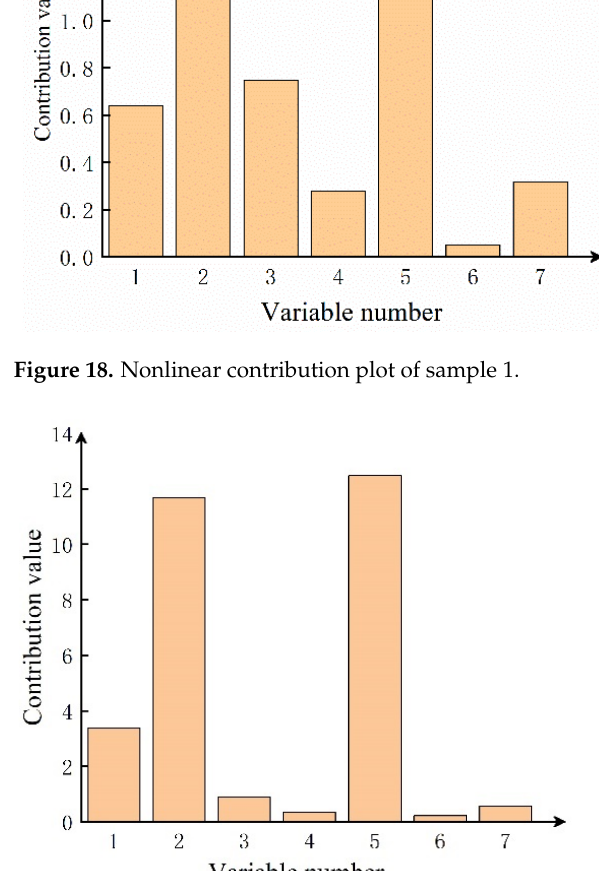
Figure 19. Traditional contribution plot of sample 2.